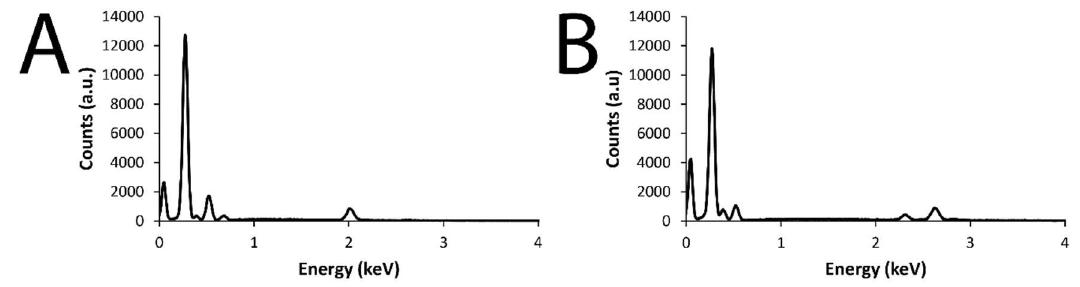
Figure 4. ( A ) EDX data from a DMP-doped PPY film; ( B ) EDX data from an MER-doped PPY film.